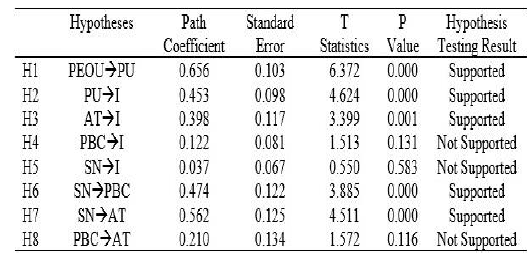
Table 4: Results of the Hypothesized Structural Model